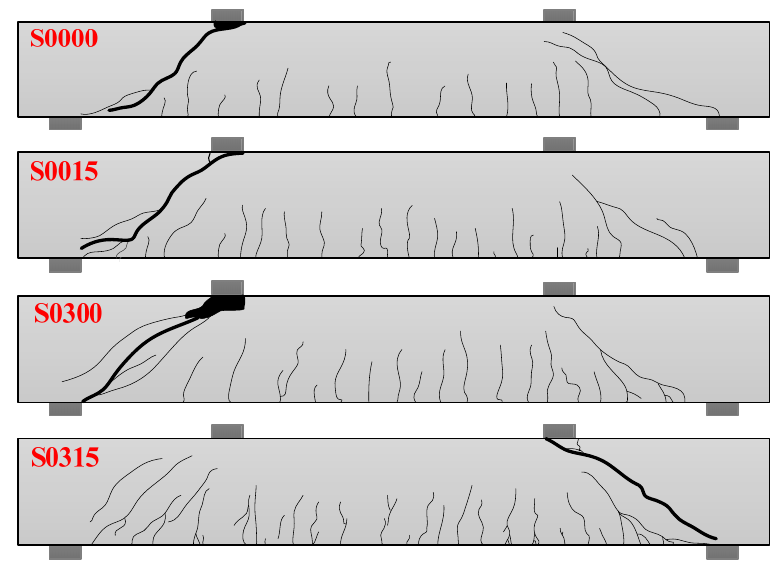
Figure 9. Failure modes.